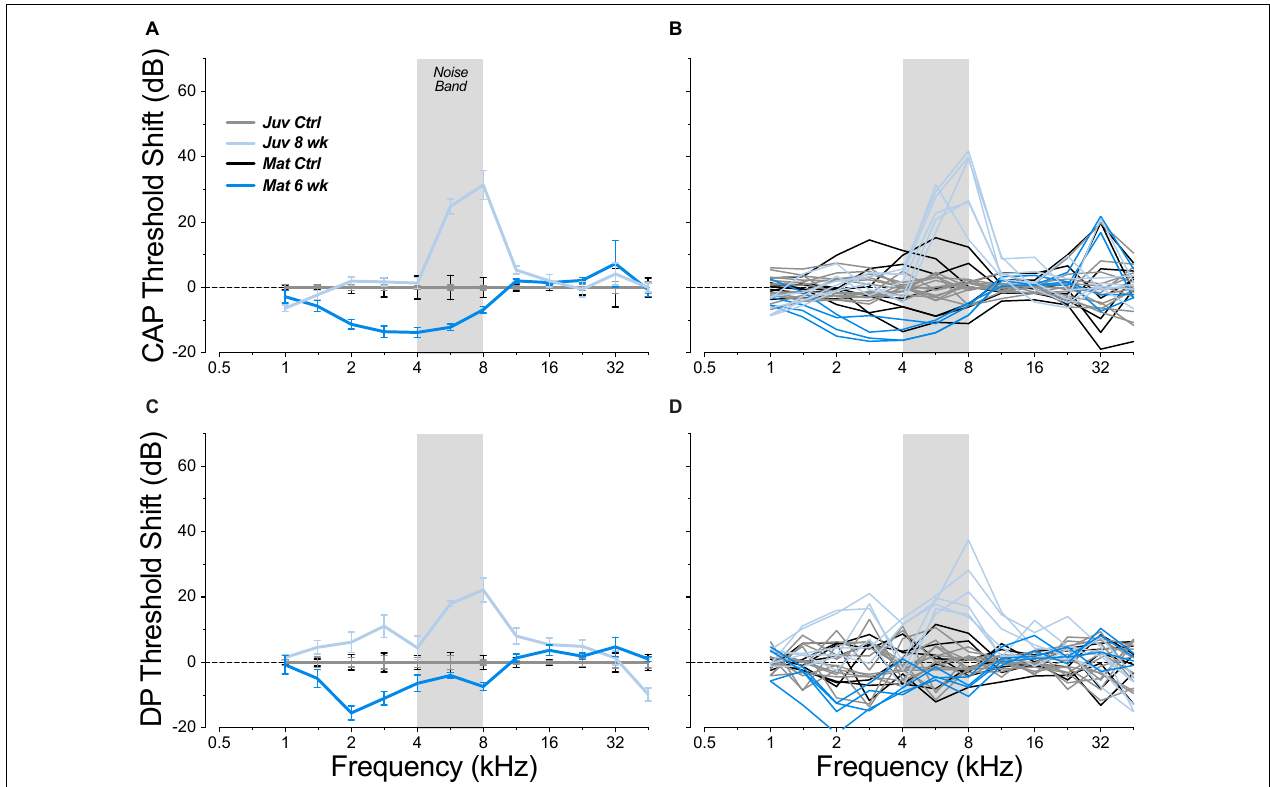
FIGURE 4 | Chronic threshold shifts, measured 6 weeks post exposure, were smaller in the mature guinea pigs than in juveniles from a prior report (Hickman et al., 2020). Threshold shifts are measured re the mean control data for the same age group (see Figure 2 ). Data are shown for CAPs (A,B) and for DPOAEs (C,D) , and each metric is plotted for individual animals (B,D) and as group means ± SEMs (A,C) . The gray bar indicates the passband of the noise exposure used to create synaptopathy. Group sizes were: mature control n = 7 ears of 4 animals, juvenile control n = 14 ears of 7 animals, mature 6 weeks n = 4 ears of 2 animals, juvenile 8 weeks n = 6 ears of 3 animals.